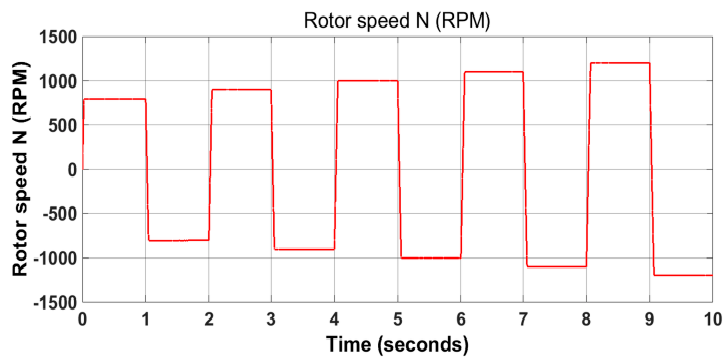
Figure 12. Actual speed of the BLDC motor for ten seconds.